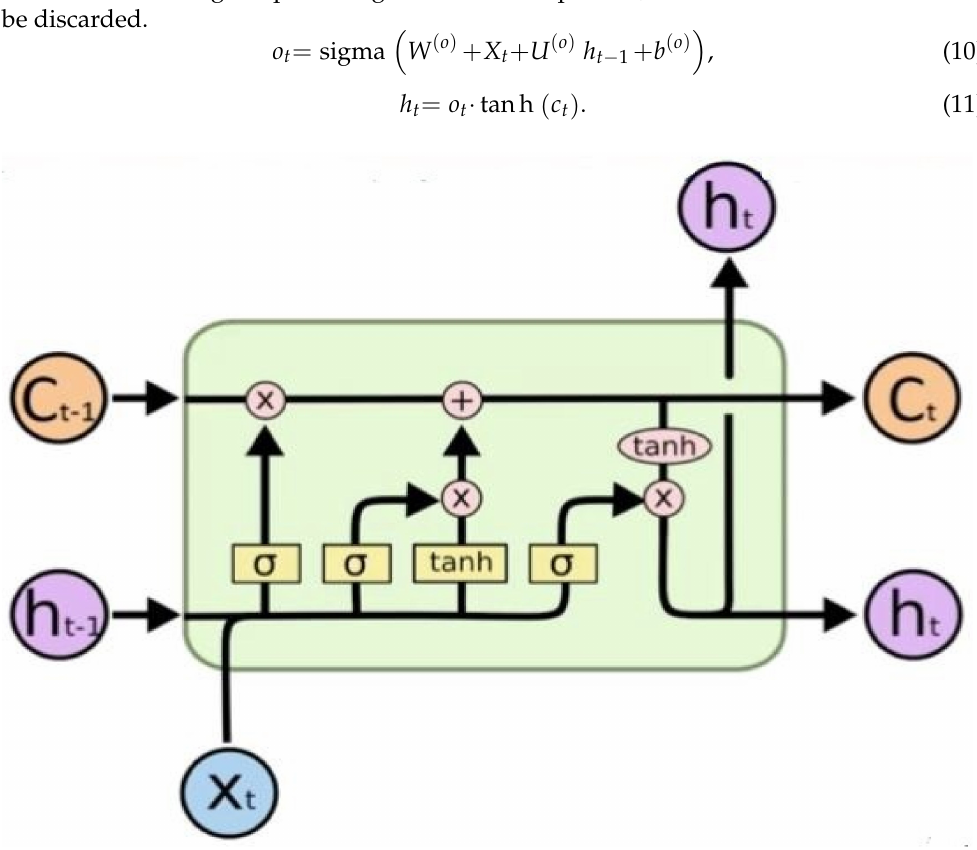
Figure 7. LSTM model’s